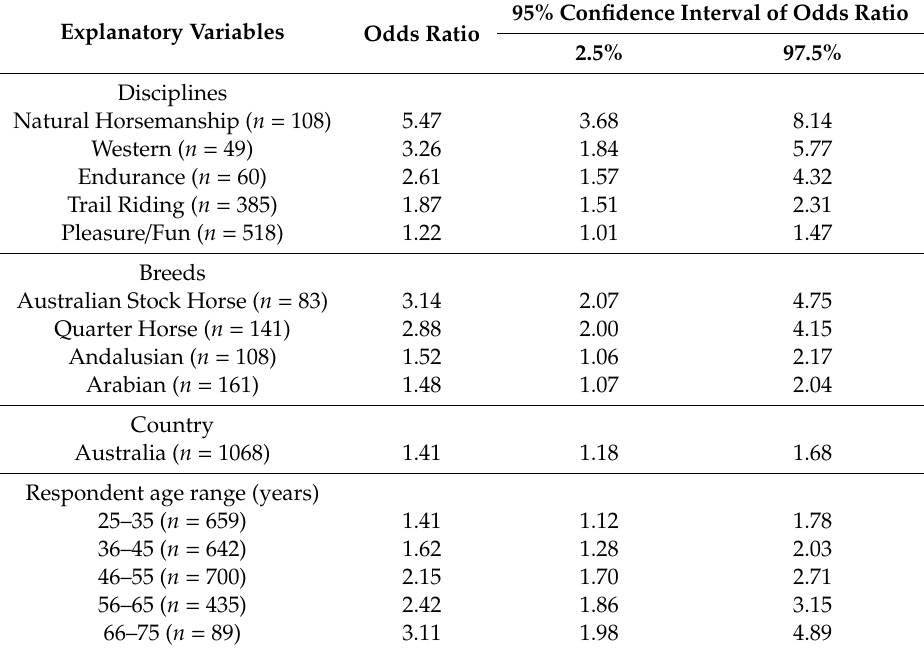
Table 1. Explanatory variables (equestrian disciplines, horse breeds, country of origin and respondent ages) associated with significantly increased odds of less noseband use compared with riders 18–25 for age, or the study mean for other types of variable. 95% Confidence Interval of Odds